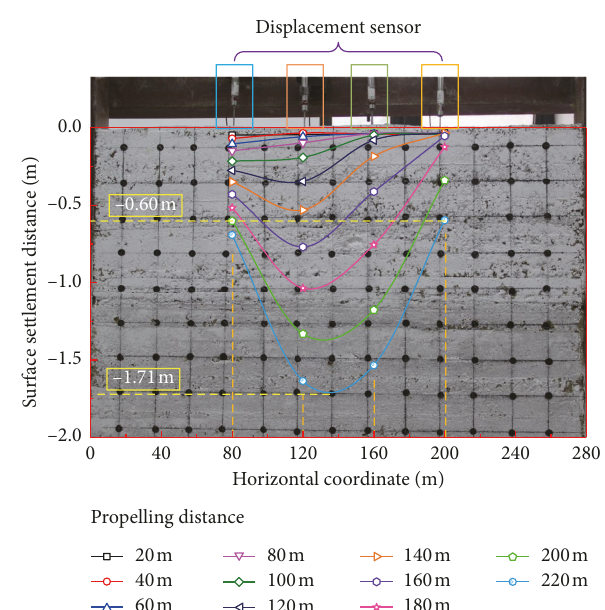
Figure 7: Model of vertical displacement on the surface of the model.